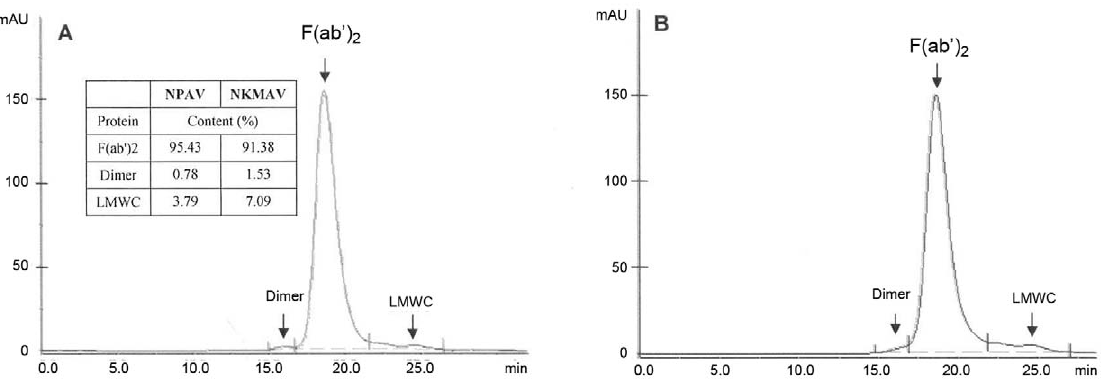
Figure 2. Elution profiles of (A) Neuro Polyvalent Snake Antivenom (NPAV) and (B) Najakaouthia monovalent antivenom (NKMAV). One mg of each sample was applied to Superdex 200 10/300 GL gel column. The arrows identify the peaks. The results of integration of the areas- under-the-curve are shown in the insert table on the upper left. LMWC stands for low molecular weight components.